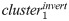
Identification of clustered inversion evidences.(a) The solid gray arrow represents the beginning loci on the original chromosome, and its mapping location on the reference is pointed by a dotted arrow. The maximum inverted region of a cluster C1 can be determined by union the inverted regions from all its supporting reads; (b) C1 and C2 can be clustered together using the union operator to join cluster1invert and cluster2invert.